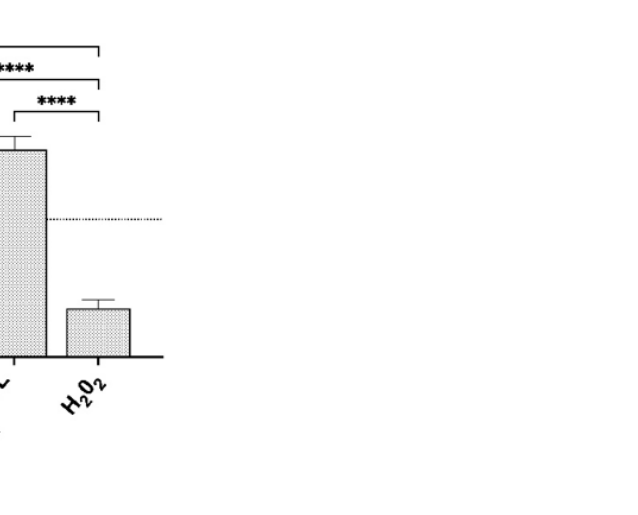
Figure 7. The viability of mHippoE-18 cells exposed for 24 h to CH and CH/NGF-µS/PCL conduits. Data are shown as the mean viability ± standard deviation ( n = 6) compared to cells grown in the presence of BCS reference biomaterial ( n = 6). Values with statistically significant differences are labeled by brackets and asterisks: **** p < 0.0001. Data were compared using an ordinary one-way ANOVA followed by Tukey’s multiple comparisons.